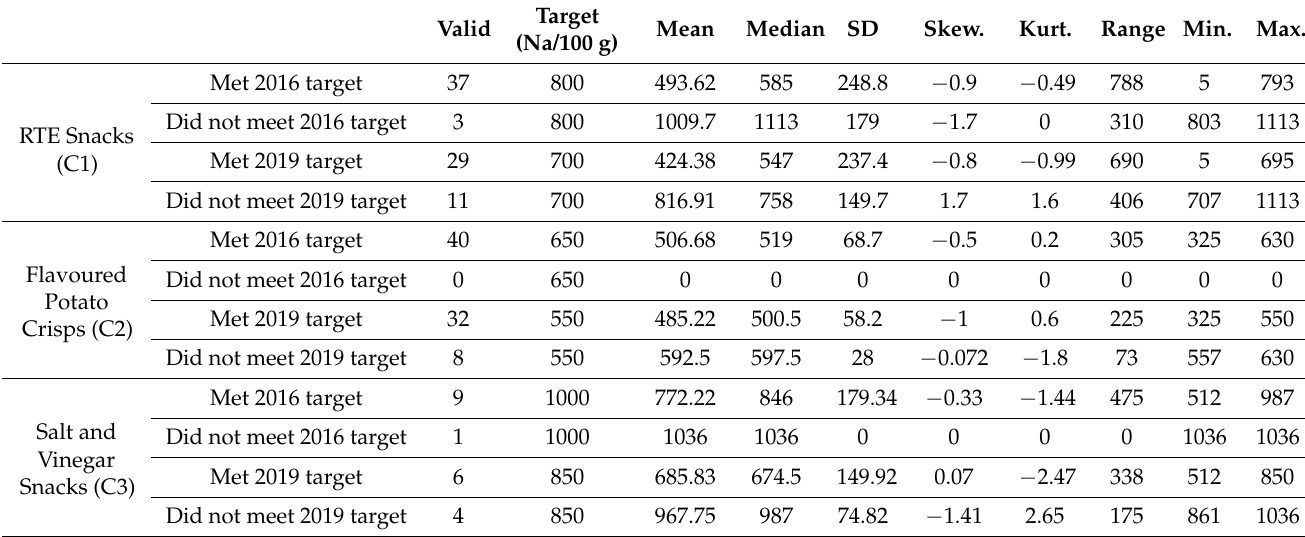
Table 3. Descriptive summary—all